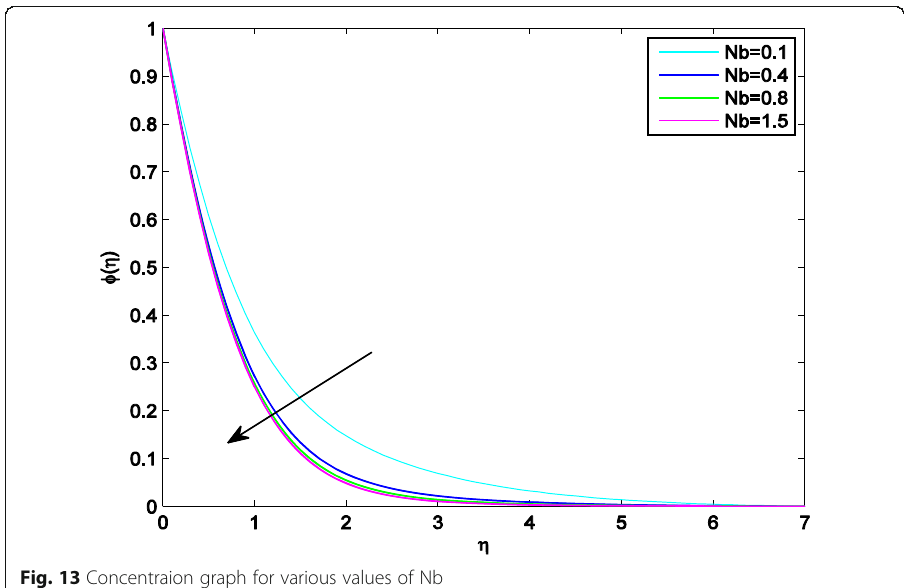
Fig. 13 Concentraion graph for various values of Nb